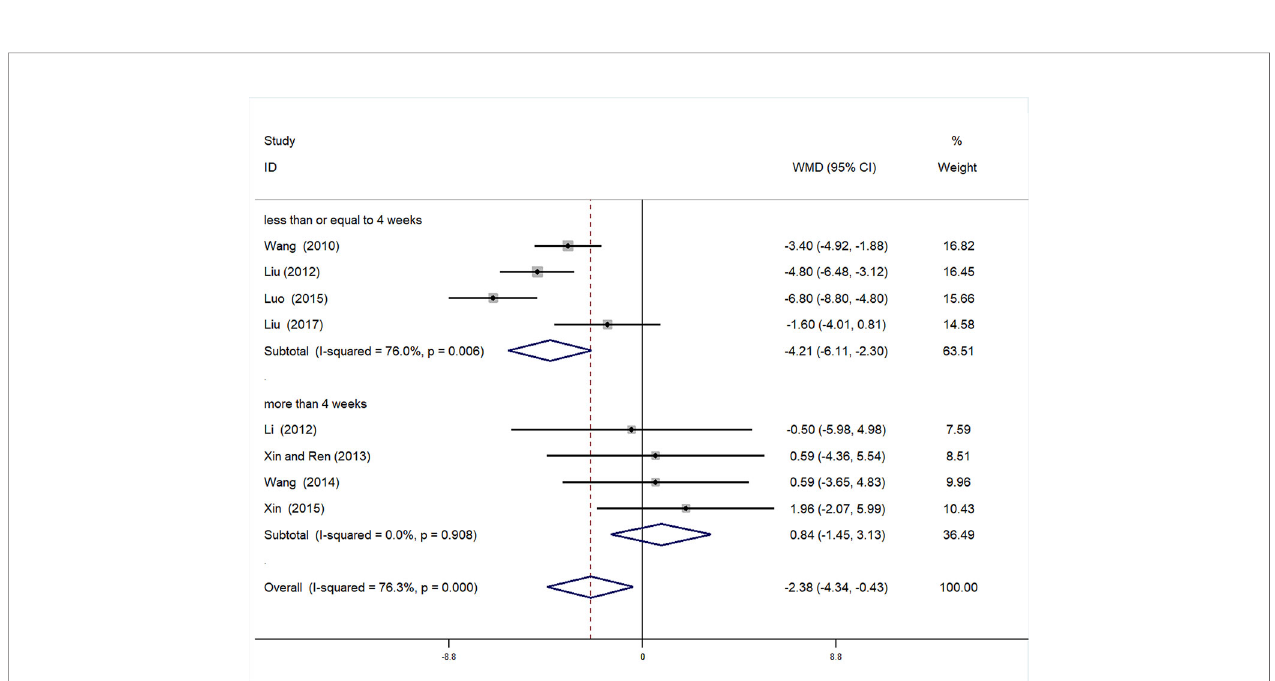
FIGURE 9 | Subgroup analysis of